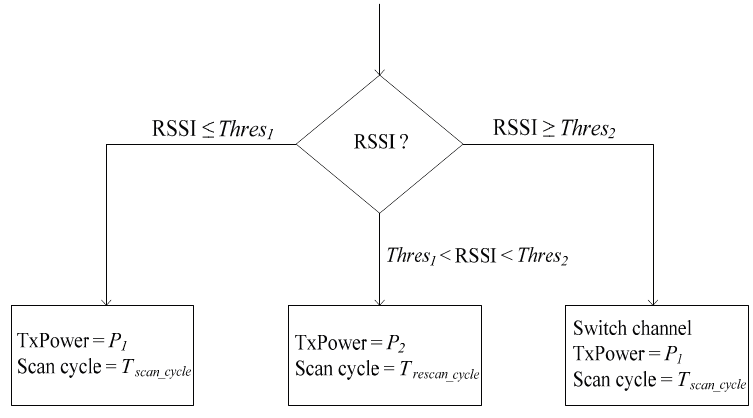
Figure 4. Power adaption strategy in C-RICER. RSSI, received signal strength indicator; TxPower, transmission power.